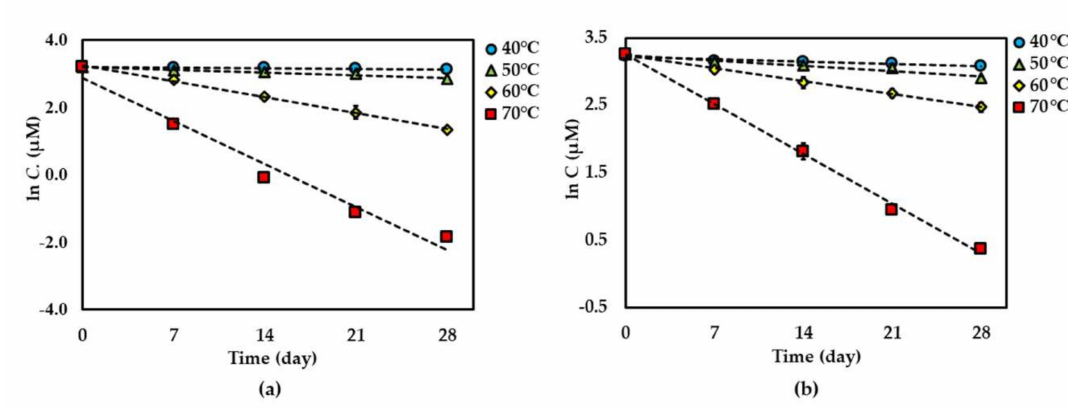
Figure 2. Thermal degradation kinetics for compound 1 in ( a ) dried Aquilaria crassna aqueous leaf extract (AE) and ( b ) AE solution as fitted to a first-order kinetic model at 40 ◦ C–70 ◦ C for 28 days. The plotted points are mean ± SD ( n = 3).